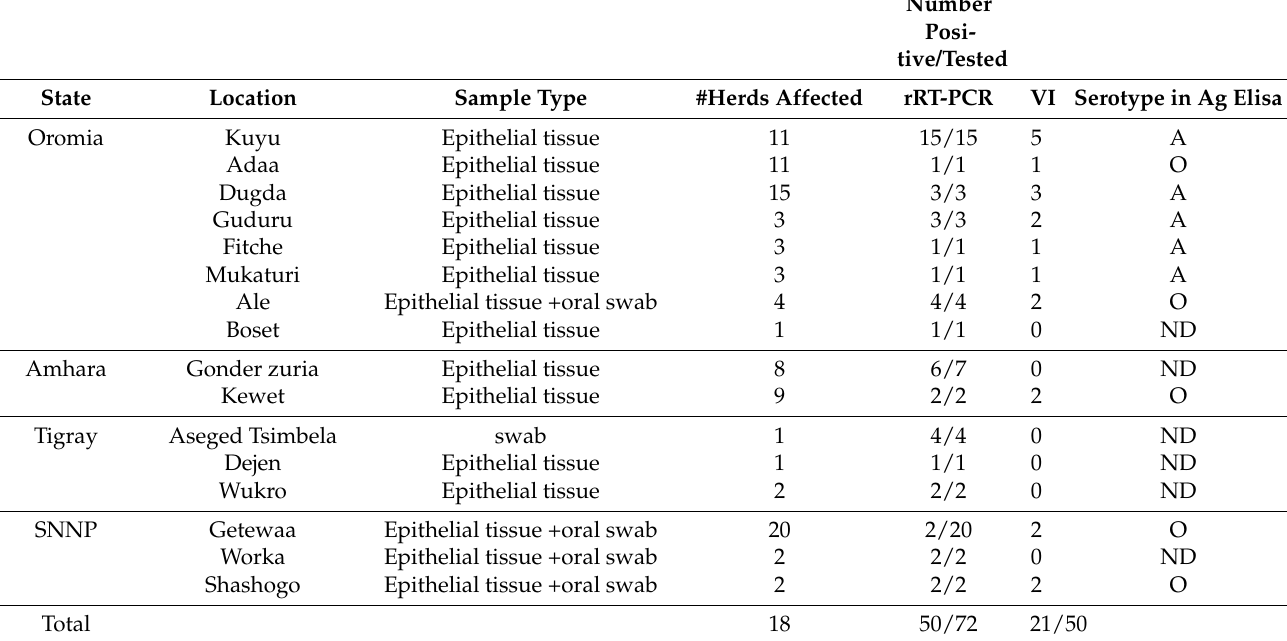
Table 7. Diagnostic results of tissue samples from FMD outbreaks in cattle in Ethiopia from September 2018 to September